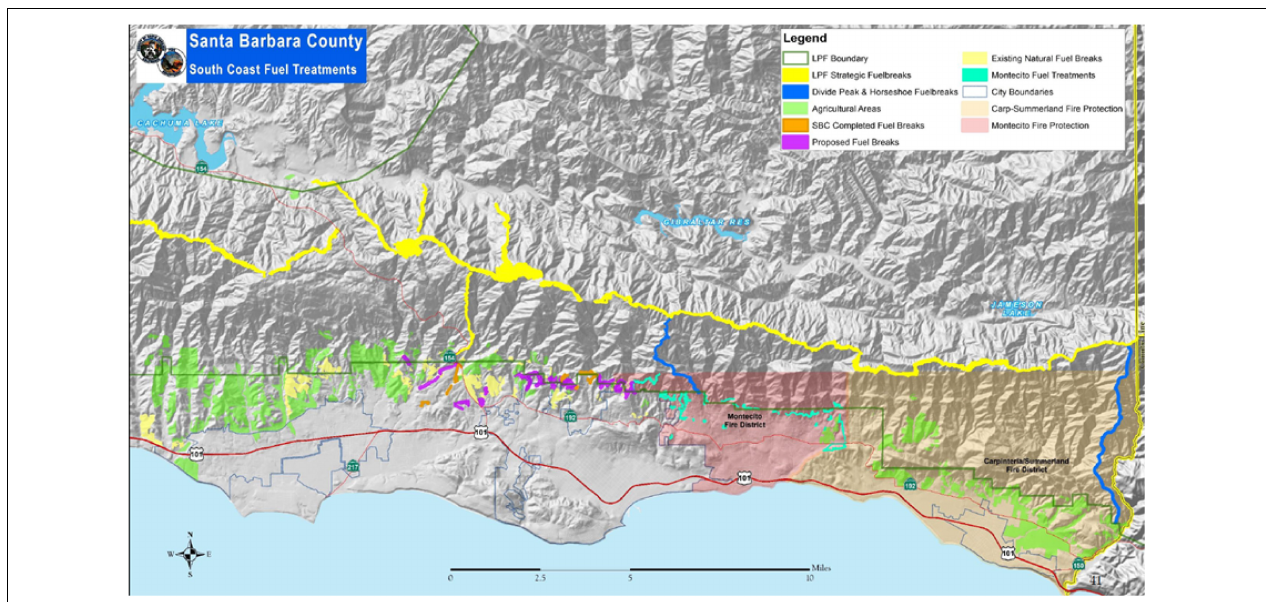
FIGURE 9 | Santa Barbara, CA, United States, showing different fuel types and treatments in a portion of the first RWMP. Note that there are still agricultural lands that act as a buffer against fire in eastern and western portions of the RWMP study area; they are missing now in the central portion of this map, and this is historically where home losses occur. Most of the flatter areas by the coast are heavily developed, with ample opportunities for retrofits to the built environment and training for communities. (See https://rwmpsantabarbara.org/ for additional